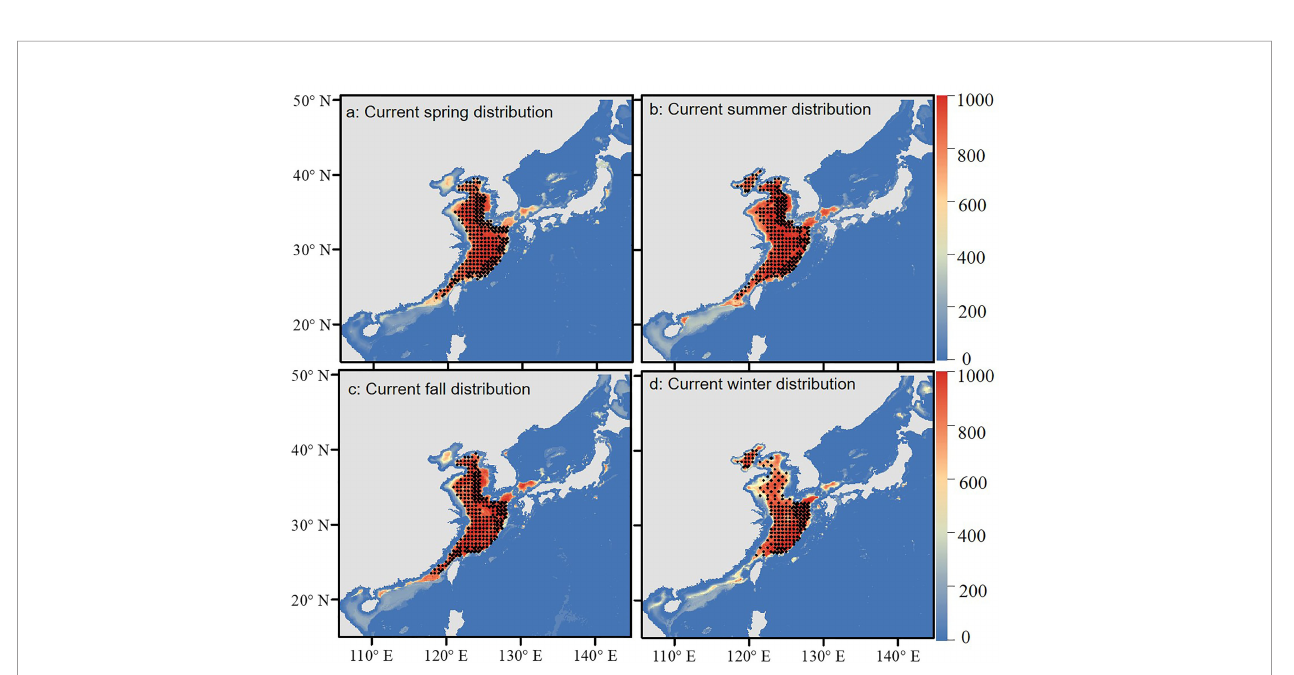
FIGURE 4 | Current simulated habitat and actual survey sites of Scomberomorus niphonius. The color gradient indicates variation in habitat suitability (red: highest, blue: lowest). The black dots represent the actual survey sites. (A – D) represent suitable habitats in spring, summer, autumn and winter respectively.